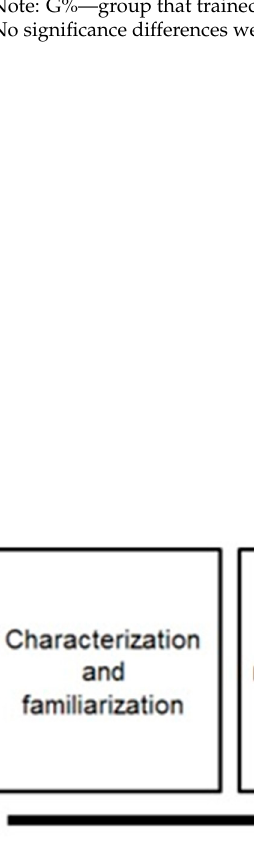
Figure 2. Timeline of the experimental procedures. Note: G%—group that trained using loads determined by 1RM; GPE—group that trained using loads determined by perceived exertion (RPE).